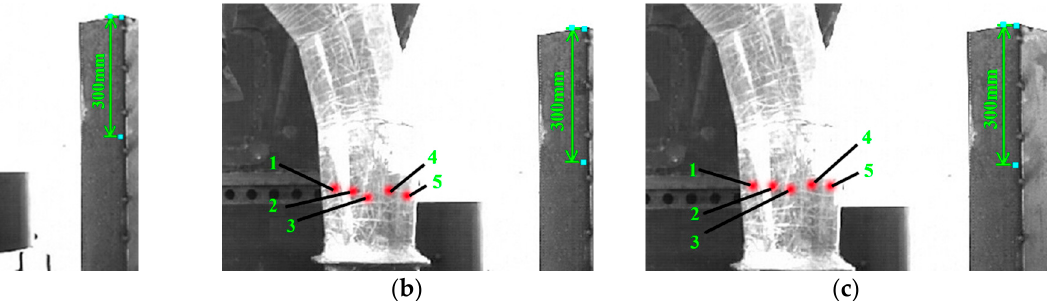
Figure 16. Movement process of crushed straw material near section A. ( a ) t = 1.540 s. ( b ) t = 1.542 s. ( c ) t = 1.544 s.